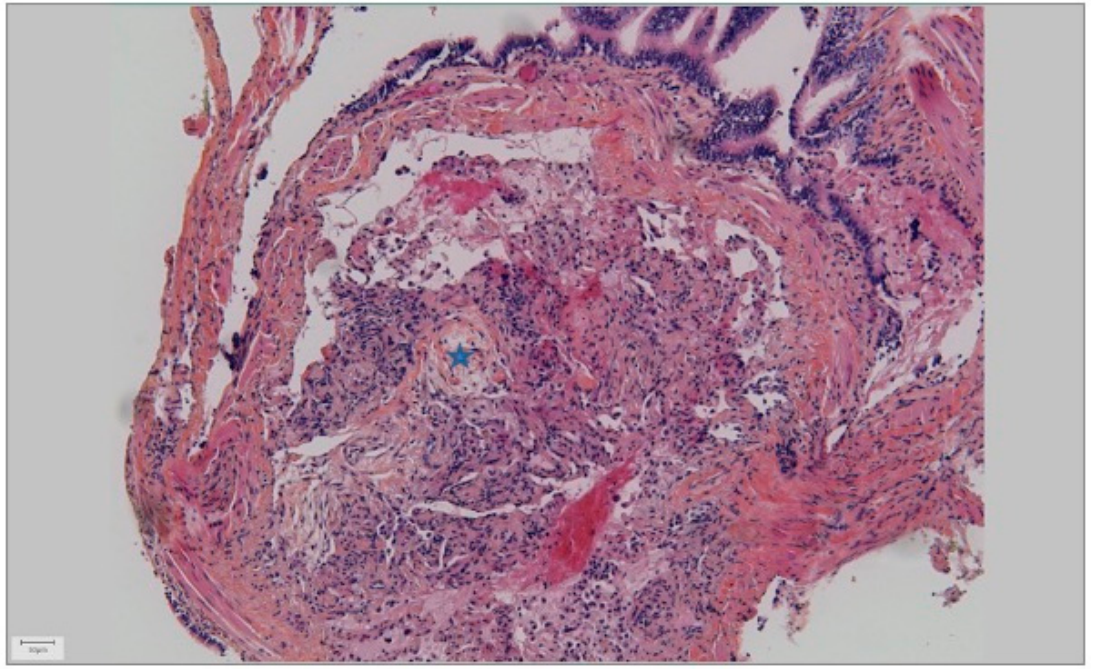
Figure 3. Pathology of organizing pneumonia(Star: buds of granulation tissue within the distal air spaces). air